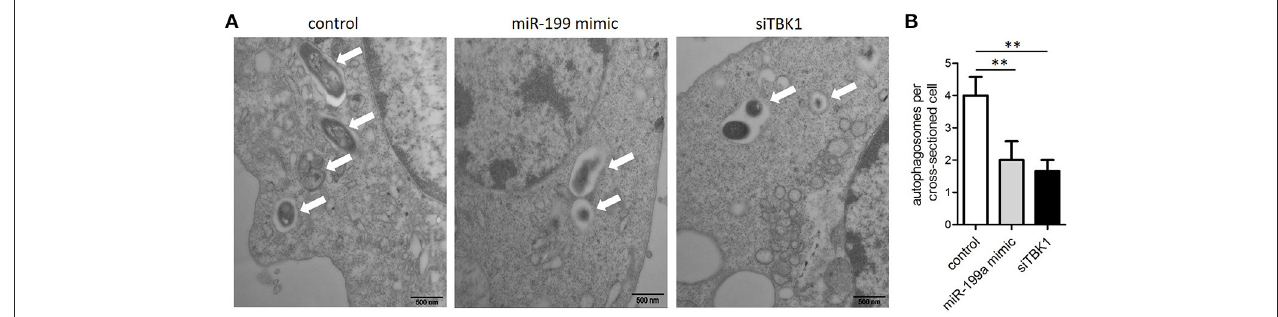
FIGURE 4 | The inhibitory effect on autophagy by miR-199a was confirmed by Transmission Electron Microscopy (TEM). J774a.1 cells were transfected with control, miR-199a mimic or siTBK1 for 24h, and then infected with M. bovis at an MOI of 10 for 24h. (A) Close-up images ( × 4,0000 magnification) of cytoplasmic regions containing autophagosomes (denoted by white arrowheads). (B) The number of autophagosomes per cross-sectioned cell was counted (20 cells per group counted by TEM). Data is presented as mean ± SD in three independent experiments (** P <